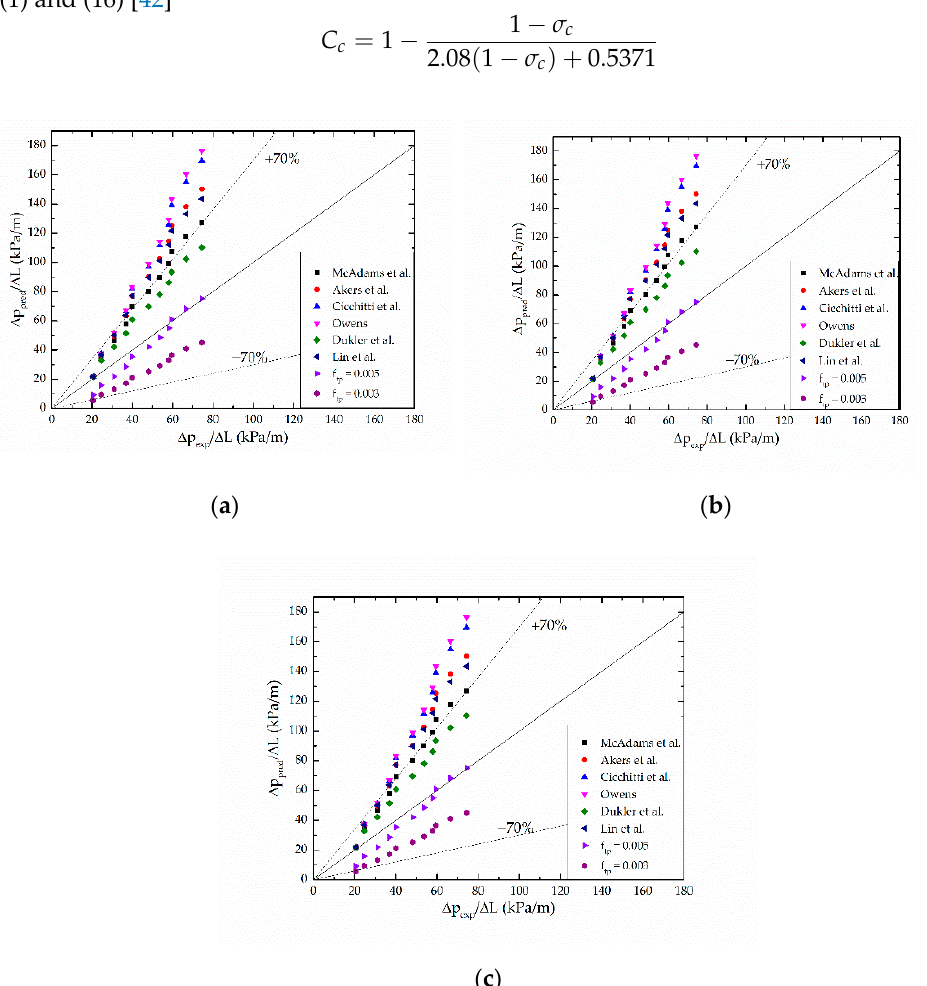
Figure 3. Comparison of predictions of homogeneous models with present experimental frictional pressure drop data calculated based on ( a ) Zivi’s model, ( b ) homogeneous model, and ( c ) Lockhart and Martinelli’ model.